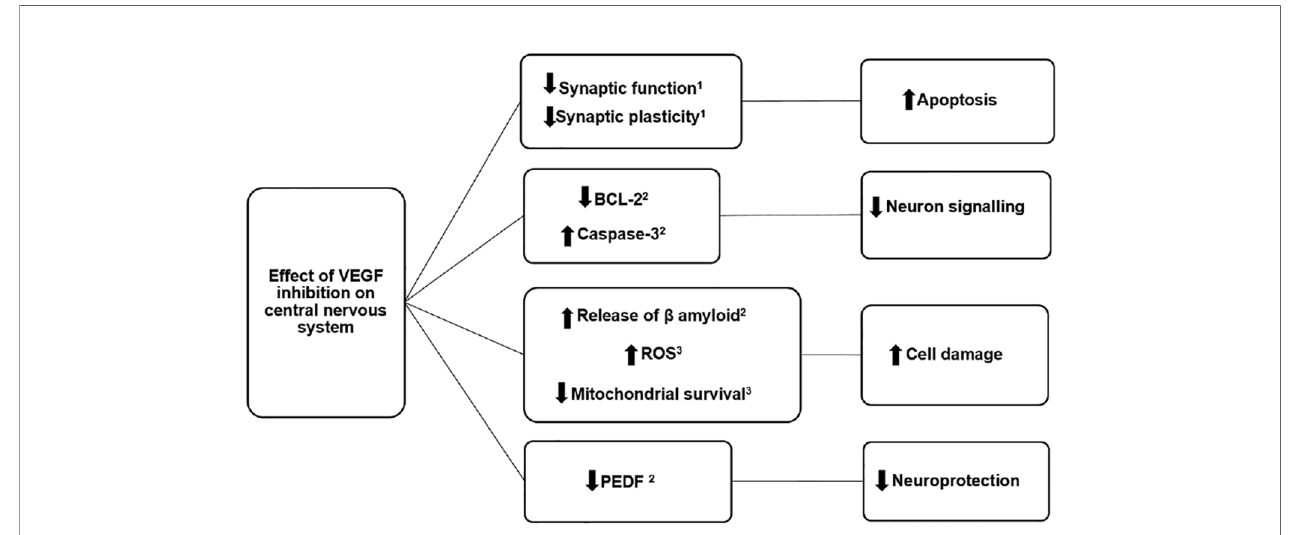
FIGURE 1 | Possible mechanisms of action by which intravitreal antivascular endothelial growth factor drugs could increase the risk of neurodegenerative disease such as Parkinson ’ s disease and Alzheimer ’ s disease. ROS, reactive oxygen species; PEDF, pigment epithelium-derived factor; VEGF, vascular endothelial growth factor. (Sanchez et al., 2010; De Rossi et al., 2016; Caballero et al.,